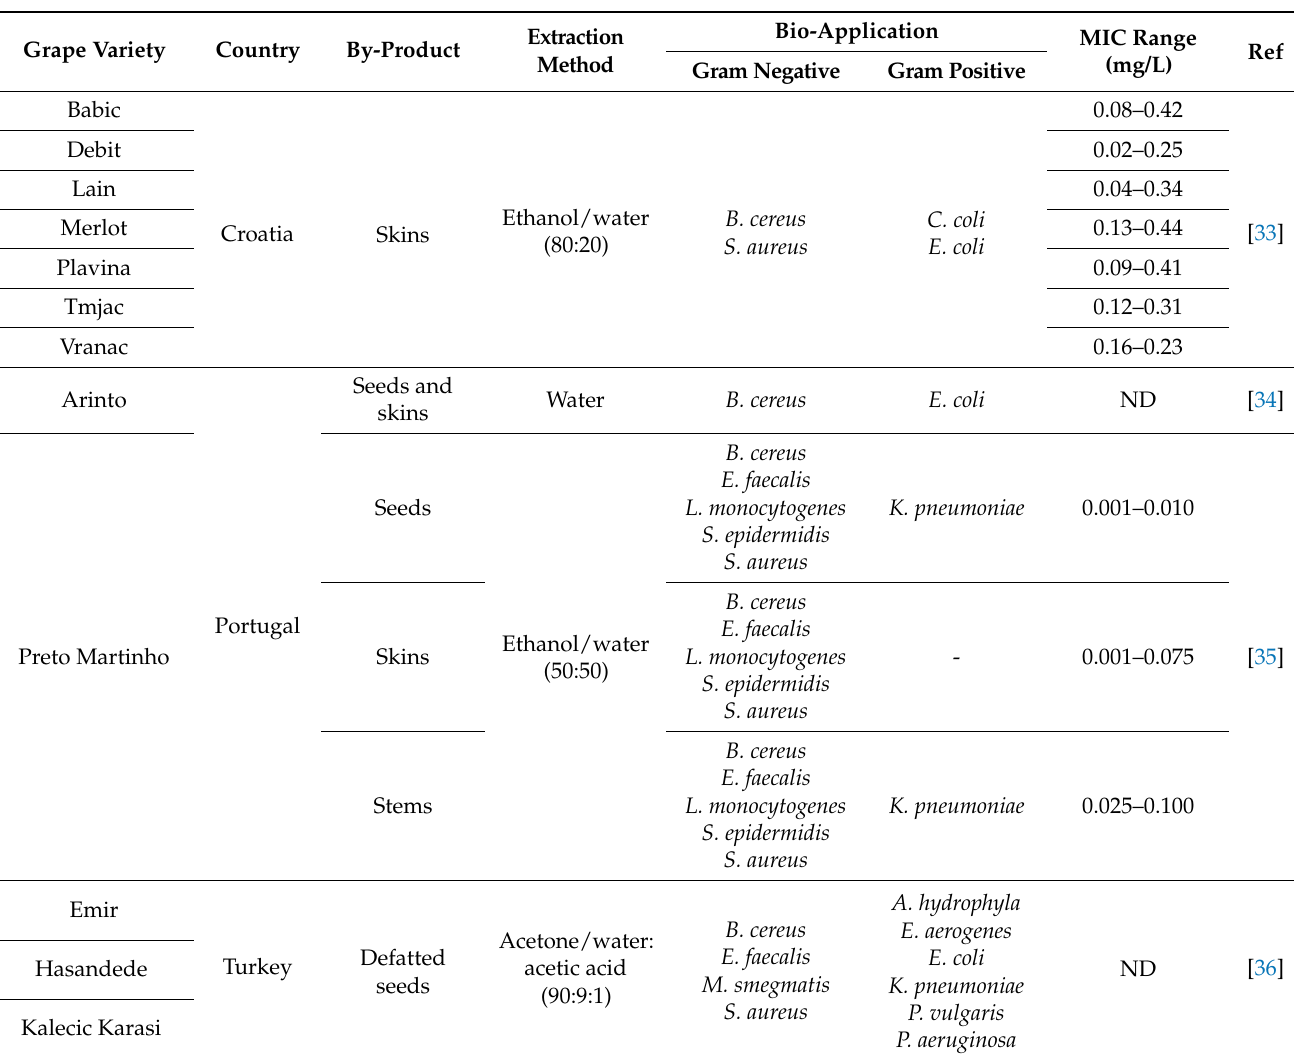
Table 2. Winery by-products as bio-active